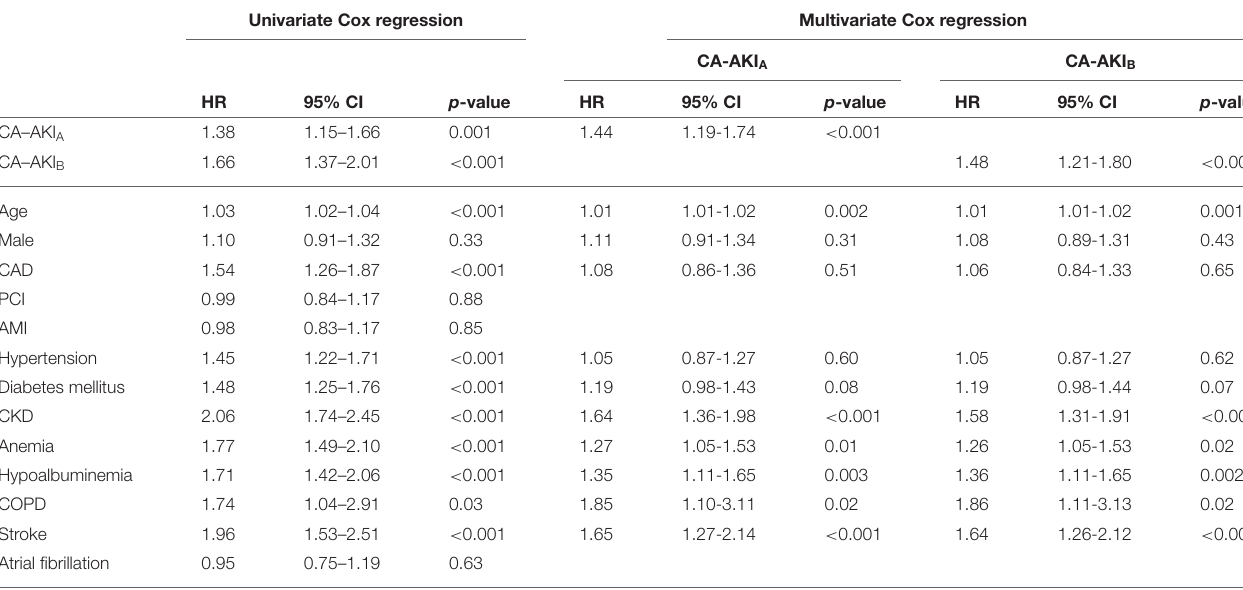
TABLE 2 | Unadjusted and adjusted hazard ratios (HRs) and 95% CIs for the primary endpoint (long-term all-cause mortality) of two different contrast-associated acute kidney injury definitions. Univariate Cox regression